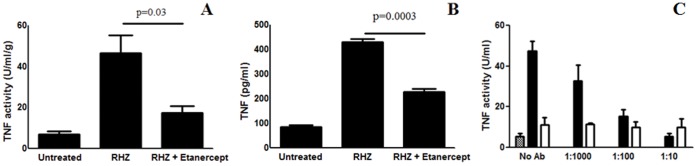
TNF-α activity in the lungs of treated mice.TNF-α activity was measured in lung homogenates obtained from Mycobacterium tuberculosis infected C3HeB/FeJ mice by WEHI assay (A) and ELISA (B). Levels for mice receiving no treatment (Untreated), standard TB treatment (RHZ) or with adjunctive etanercept (RHZ + Etanercept) were measured 7 days after the start of treatment. TNF-α activity increased with TB treatment and was abrogated by the administration of adjunctive etanercept. Moreover, to ensure that the TNF-α activity measured using the WEHI assay was indeed due to TNF-α and not other endogenous factors, lung homogenates from both the standard treatment (RHZ alone) and adjunctive etanercept (RHZ plus etanercept) arms were pre-incubated with increasing concentrations of a murine anti-TNF-α antibody and tested using the WEHI assay (C). Lung homogenates from the adjunctive etanercept arm (open bars) had consistently lower TNF-α activity which remained unaffected by pre-incubation with the neutralizing antibody. However, TNF-α activity in the lung homogenates from the standard treatment arm (filled bars) decreased in a dose-dependent manner with increasing concentrations of the neutralizing antibody, with activities at 100 or 10 fold dilutions reaching levels observed in the adjunctive etanercept arm. Analyses were performed on two-fold diluted lung homogenate from four mice per group. Data is normalized to the total protein concentration of the tissue samples and is presented as mean activity (U/ml/g) (±SD) in panels A, C and mean level (pg/ml) (±SD) in panel B.